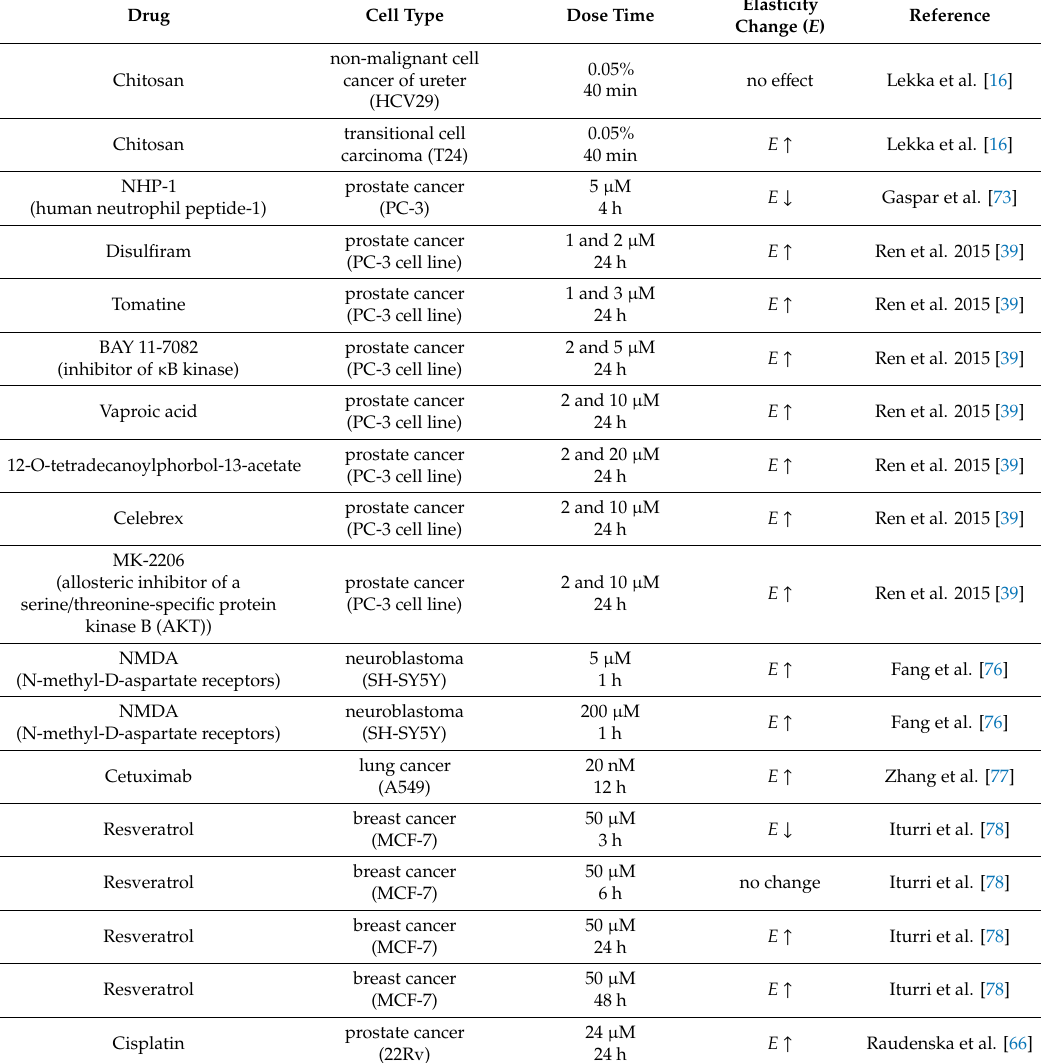
Table 2. Mechanical properties of the cancer cells treated with drugs that indirectly target